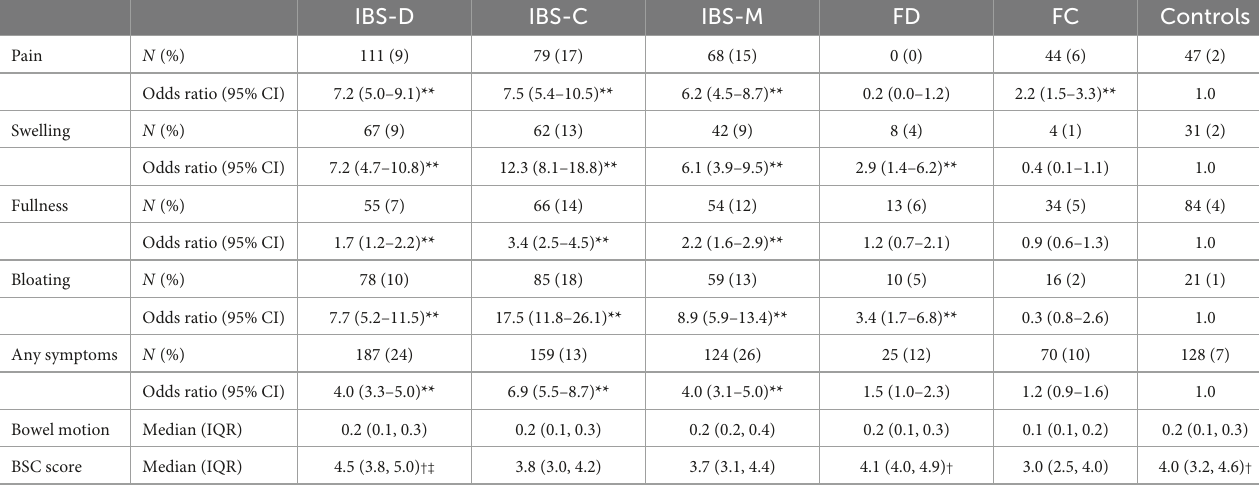
TABLE 3 Odds of post-prandial bowel symptoms by Rome IV functional bowel disorder diagnostic